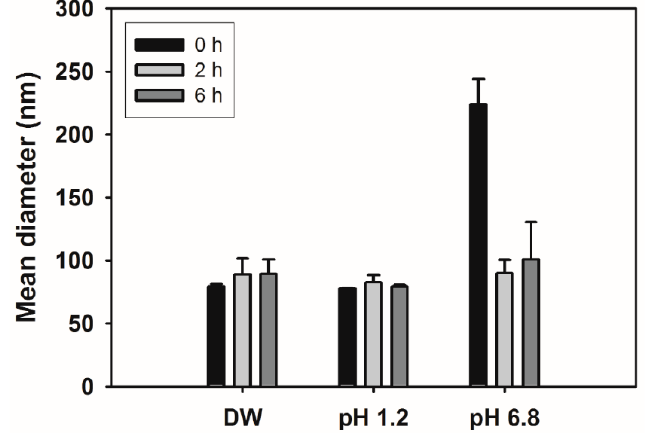
Figure 6. Hydrodynamic size of ZnSO 4 /SP NCs in DW, a pH 1.2 medium, and a pH 6.8 buffer after incubating for 6 h. Each point indicates the mean ± standard deviation (SD) ( n = 3).